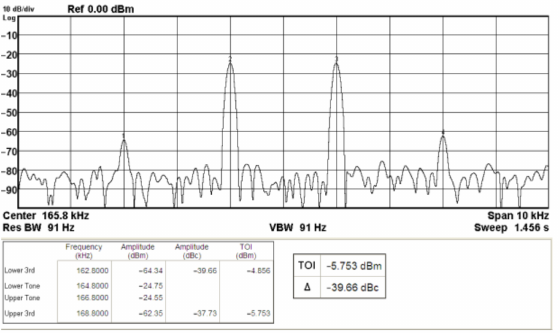
Figure 38. The NBPF at the V BP5 output spectrum for a two-tone intermodulation distortion